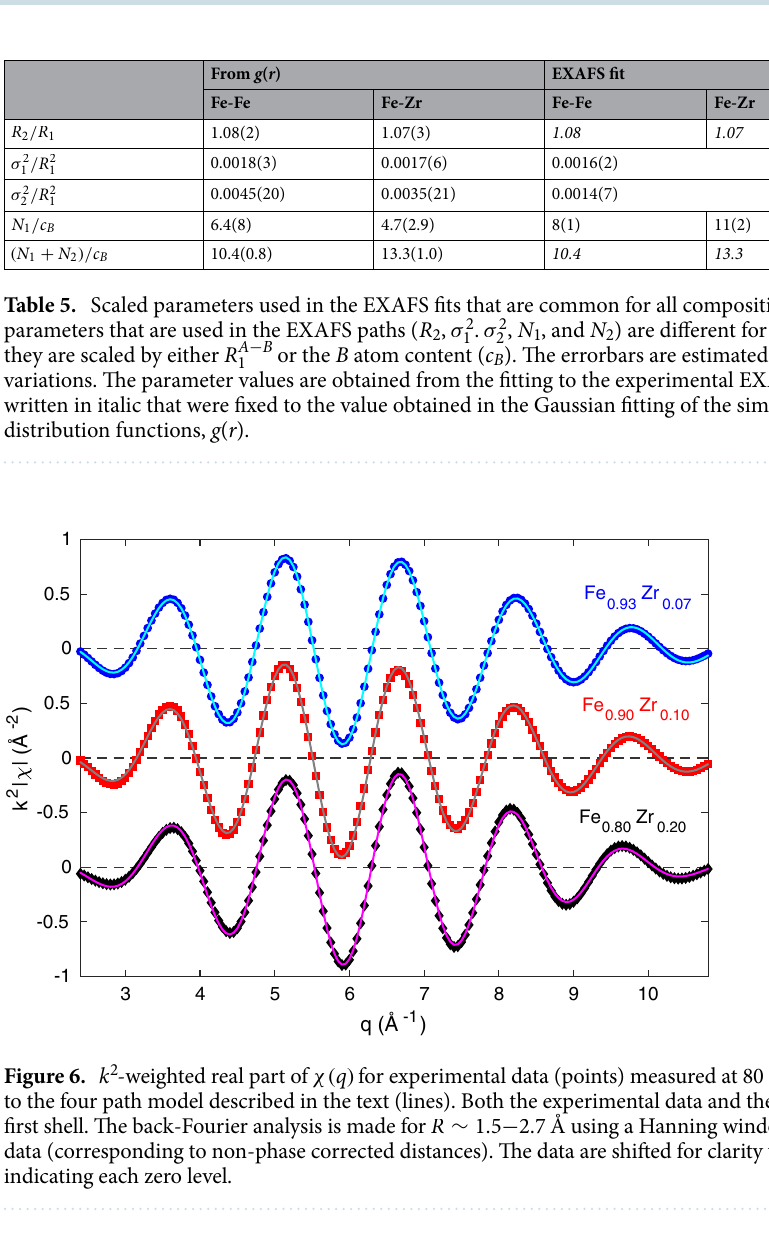
Table S2 in the Supplementary Information) and a higher Curie temperature is related to a larger Fe-Fe distance according to the Bethe-Slater curve 20 . To summarise, the Fe-Fe distances are the biggest source of discrepancy between the simulated and real amorphous structures, a difference that increases with increasing Zr content. Due to the low Zr content, we cannot draw any conclusions about the Fe-Zr distances. We only note that the uncertainties are of the same order as the discrepancies in Fe-Fe distances. The two-path approach is a simple way of obtaining an asymmetric distribution of bond-lengths. Allowing N 1 / c B to vary while keeping both the R 2 / R 1 ratios as well as the total coordination numbers fixed allow to modify this asymmetry without making the fitting procedure unstable. The coordination numbers scaled by the atomic content are in principle allowed to vary indirectly for each samples since the amplitude factors S 2 0 are fitted individually. However, the fitted S 2 0 values are within the uncertainties the same for all samples. Coordination numbers. The Fe-Fe and Fe-Zr partial coordination numbers in the EXAFS fits are obtained by summing up those of the two paths and correcting for S 2 0 . These values are reported in Table 6 and compared to the coordination numbers obtained from the simulated structures using three different methods: (i) summing up those of the Gaussians with i = 1 and 2 obtained according to Eq. (2), (ii) from the partial RDF as